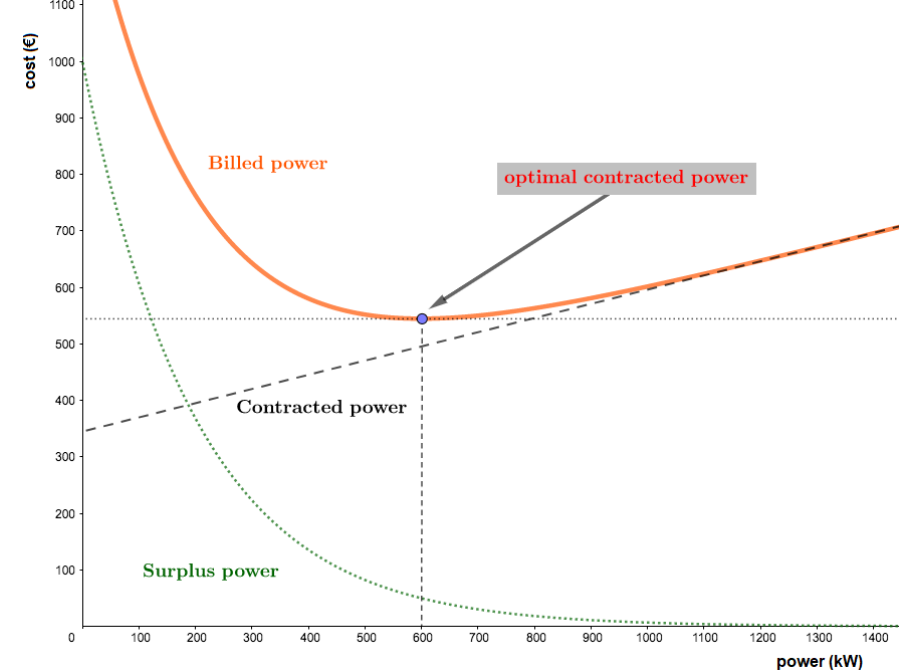
Figure 2. Example of the contribution of surplus power and contracted electric power to final power